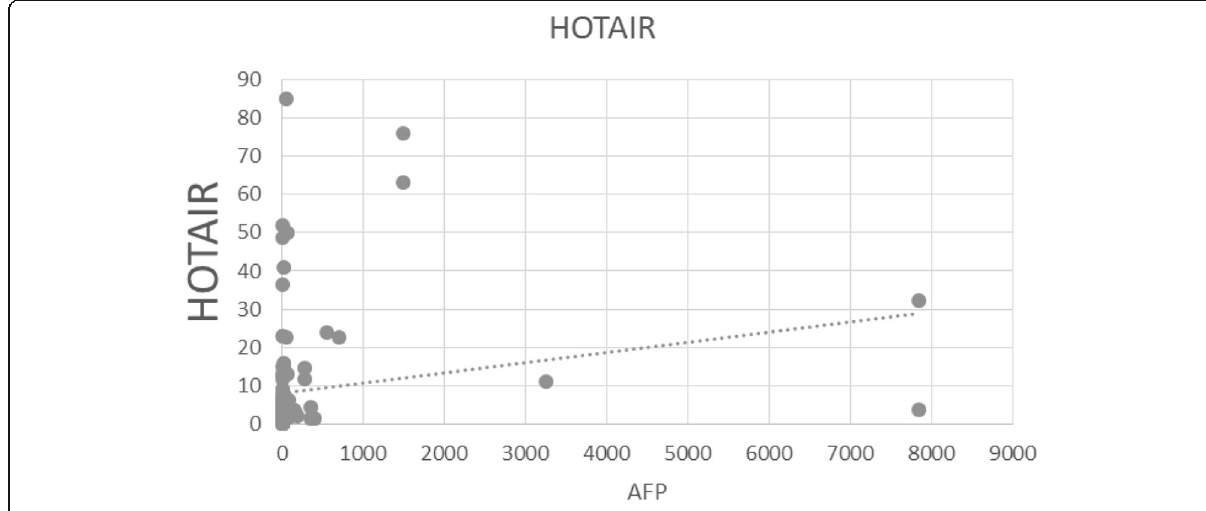
Fig. 4 Correlation between HOTAIR and AFP